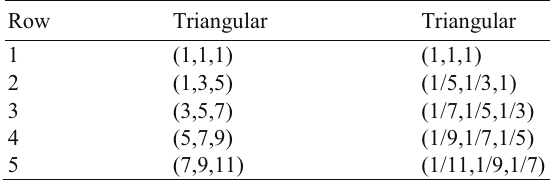
Table 2. Triangular fuzzy conversion